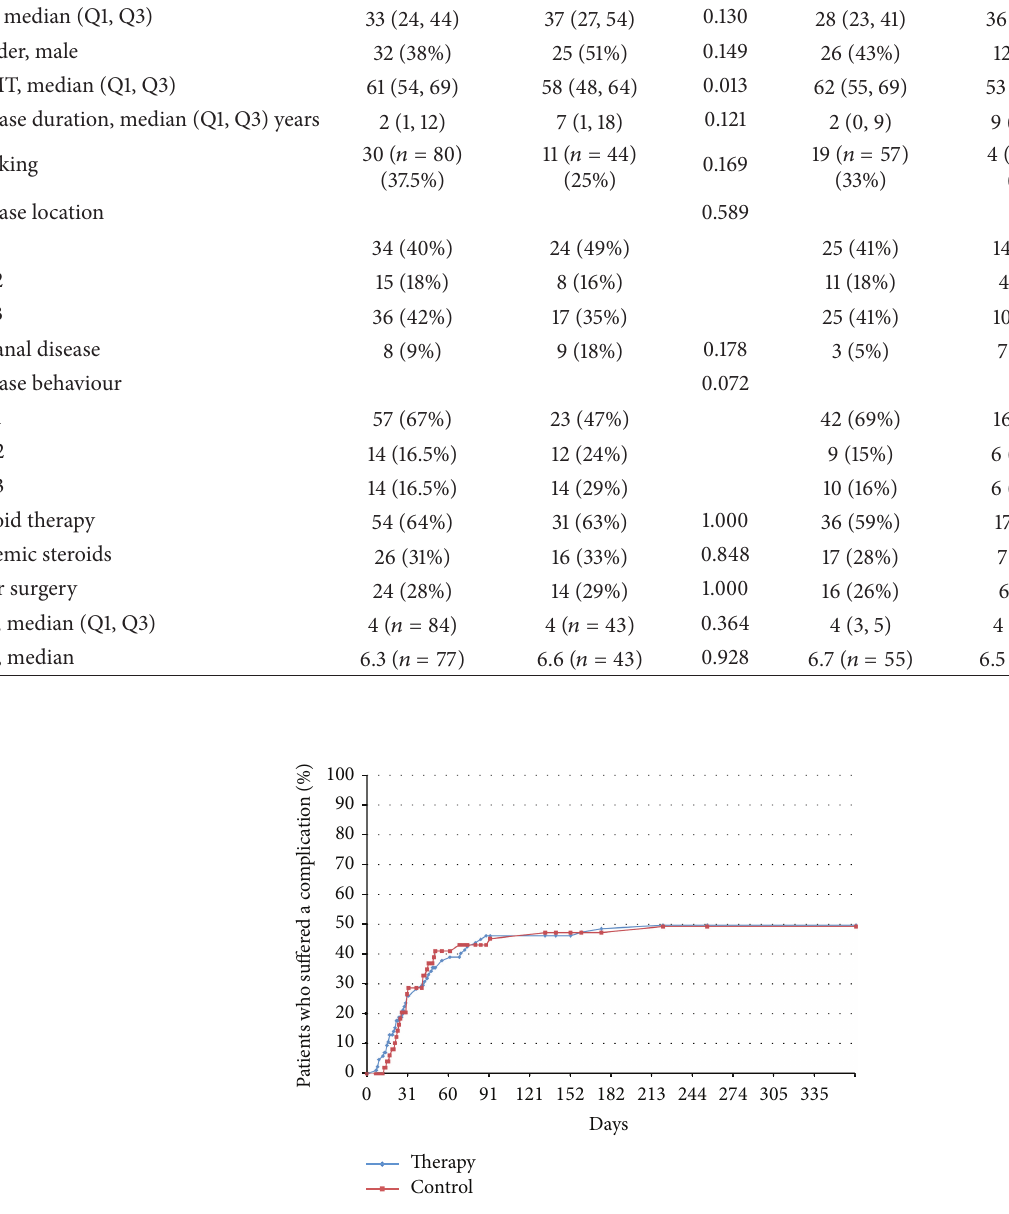
Figure 1: Incidence of toxicity in the full-dose (therapy) group compared to the low-dose (control)